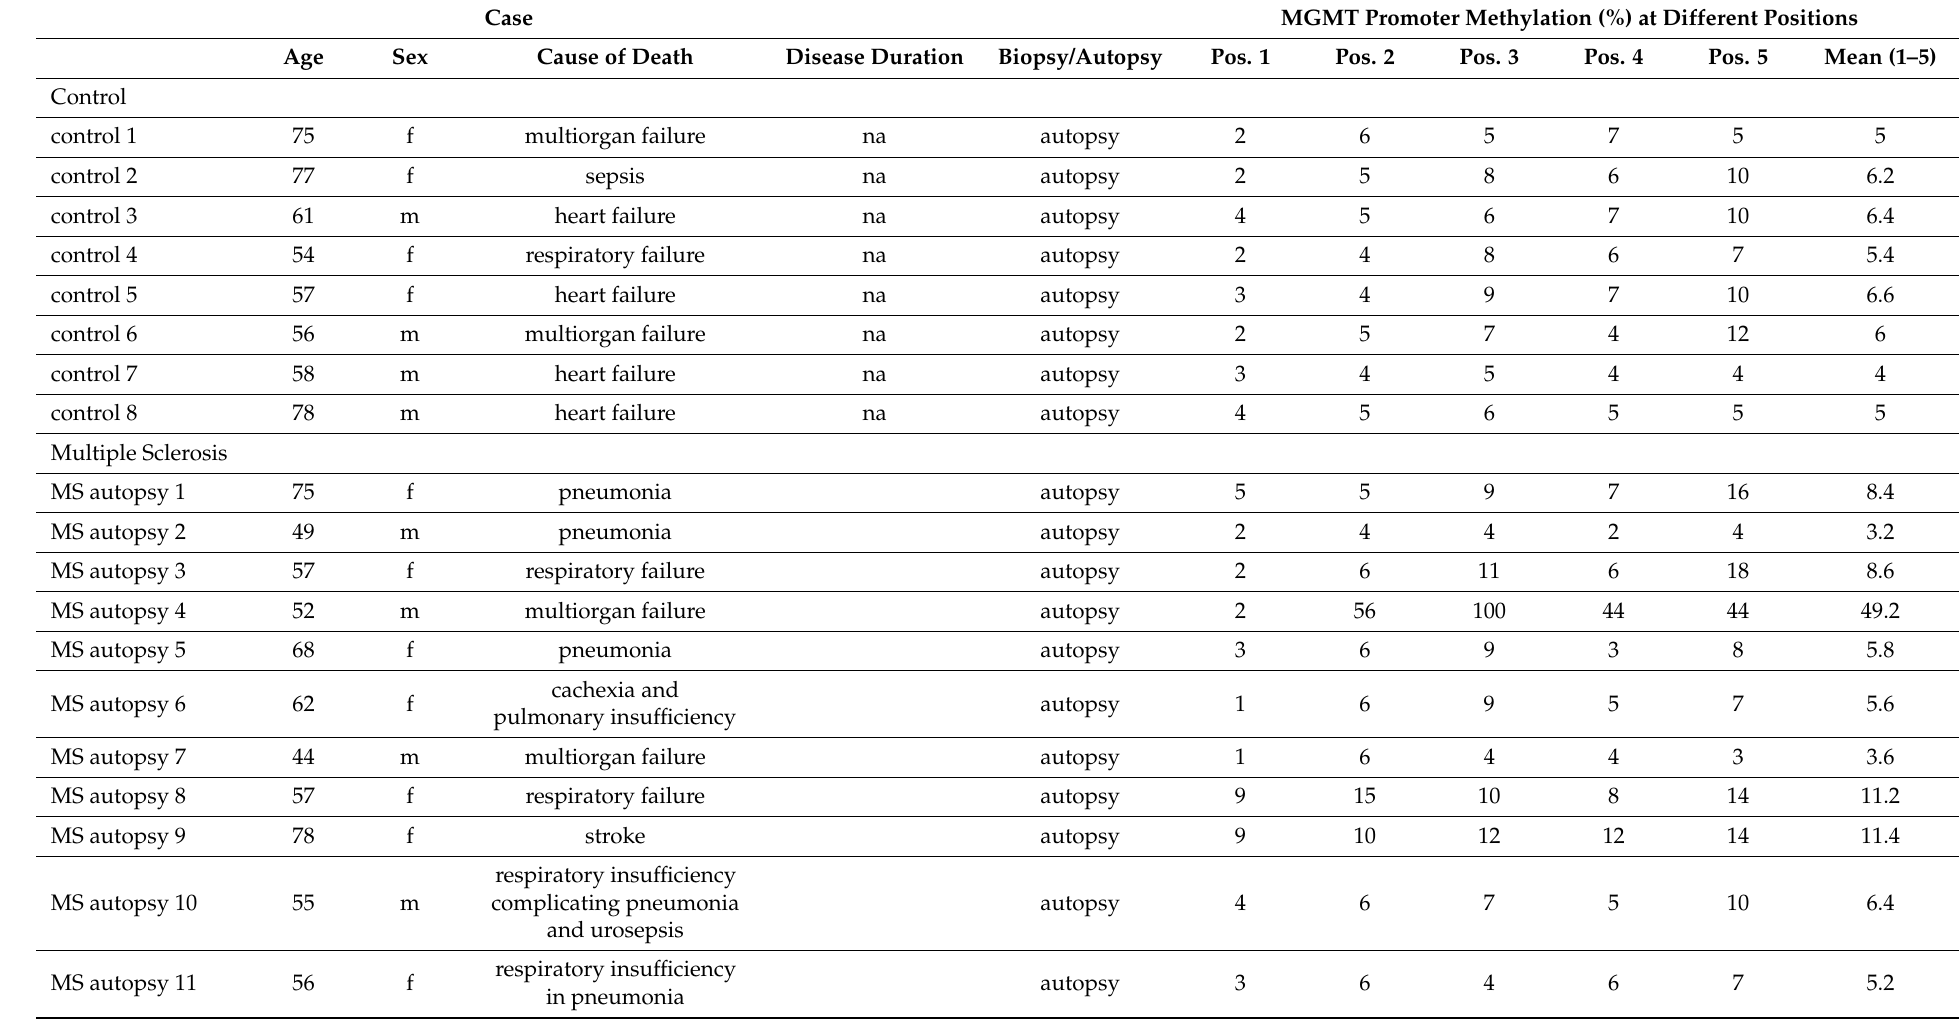
Table 1. O 6 -methylguanine-DNA methyltransferase (MGMT) promoter methylation of the five measured CpG sites in the MGMT